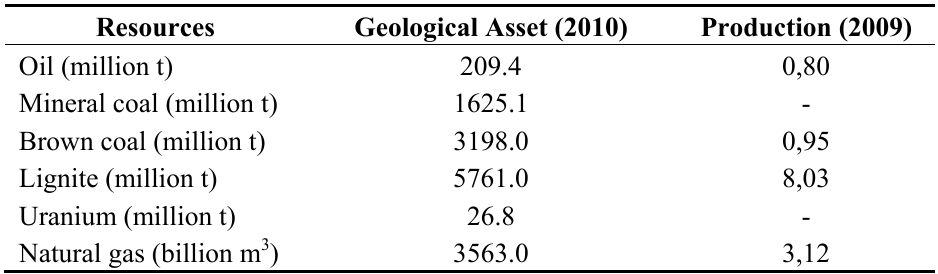
Table 1. Mineral resources in Hungary